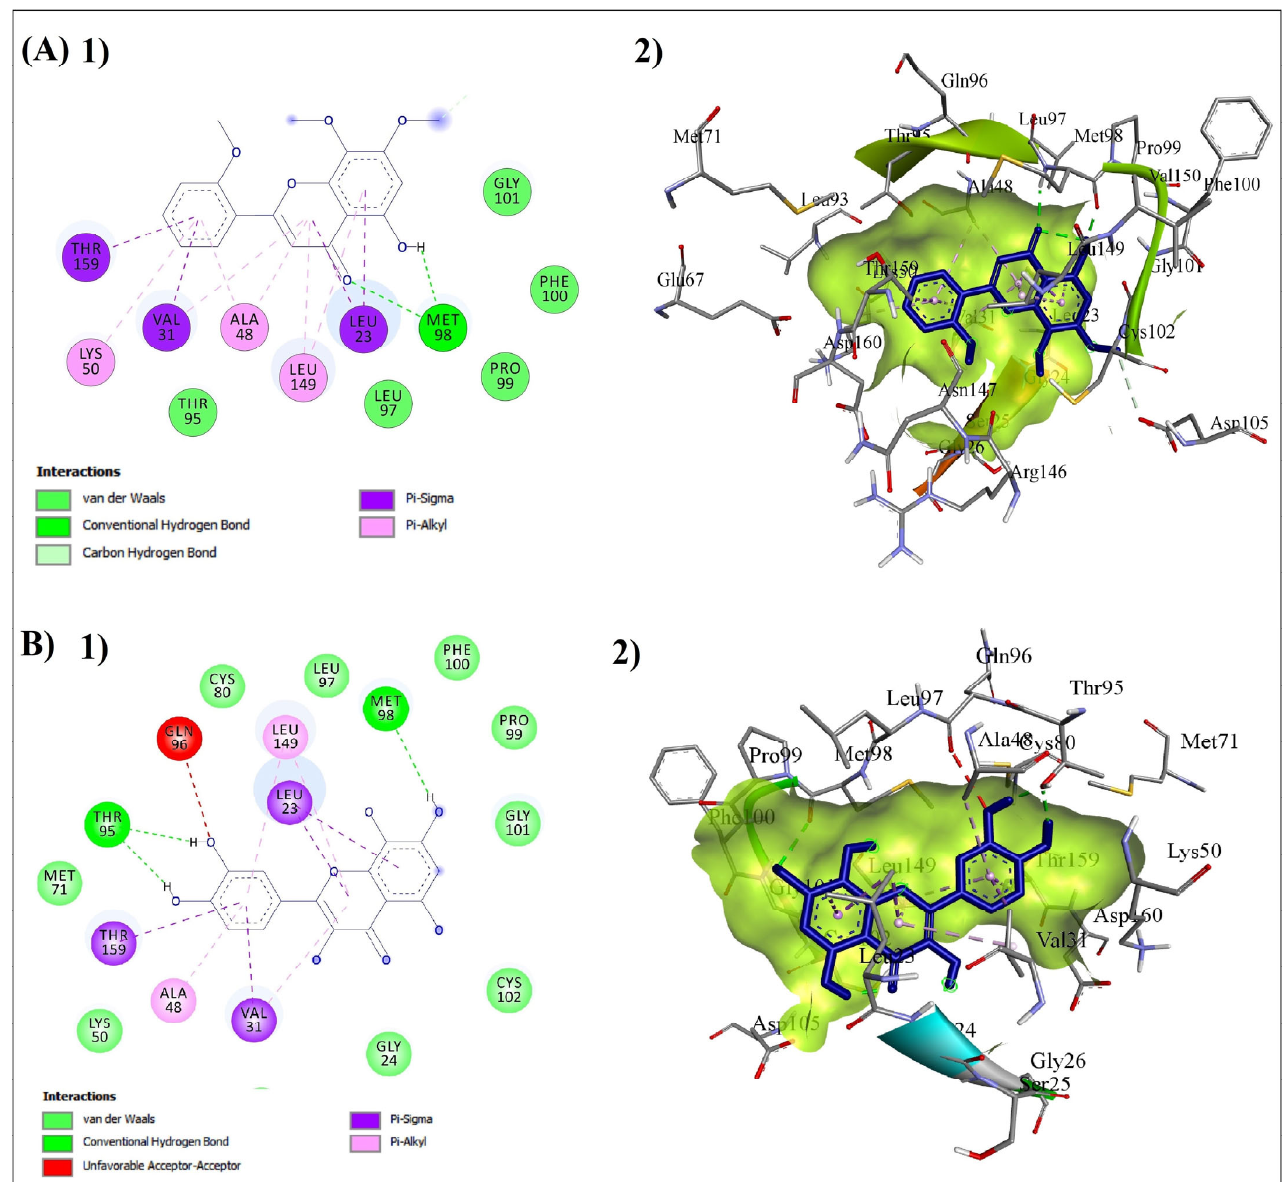
Figure 5. Intermolecular interactions of ( A ) Andrographin and ( B ) Gossypetin with WT–EGFR; (1) 2D representation and (2) 3D representation of compounds within the binding